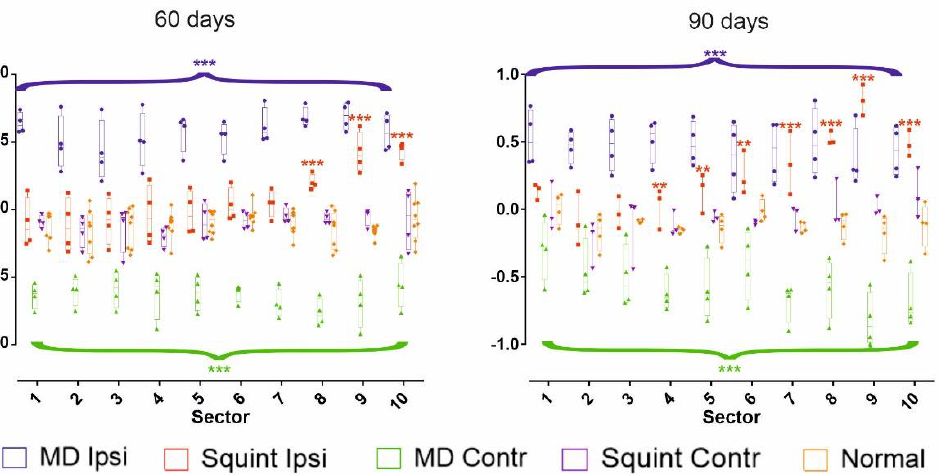
Figure 3. D-values in kitten groups aged 60 and 90 days. ** p < 0.01, *** p < 0.001—significance level with respect to the normal